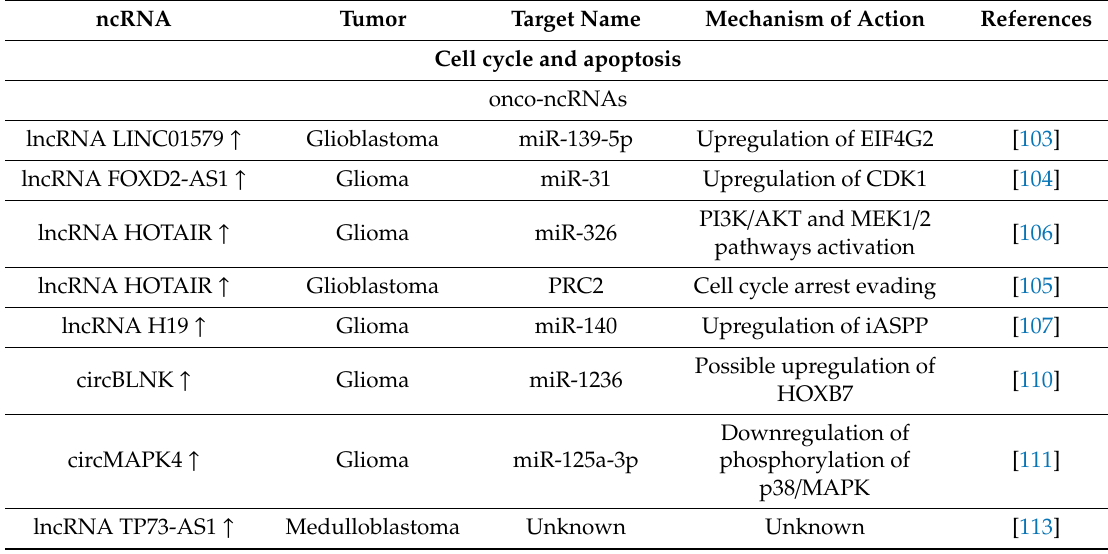
Table 1. Oncogenic or tumor-suppressive lncRNAs, circRNAs, and snoRNAs involved in the regulation of cell cycle and